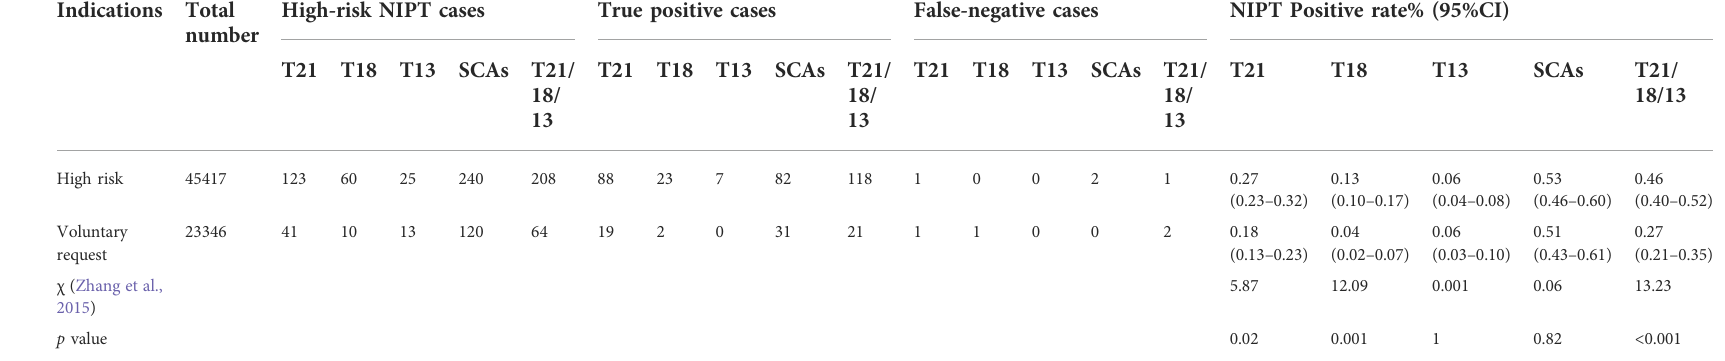
TABLE 6 Comparison of the screening ef fi ciency of NIPT between low-risk and high-risk pregnancy women. Indications Total High-risk NIPT cases number